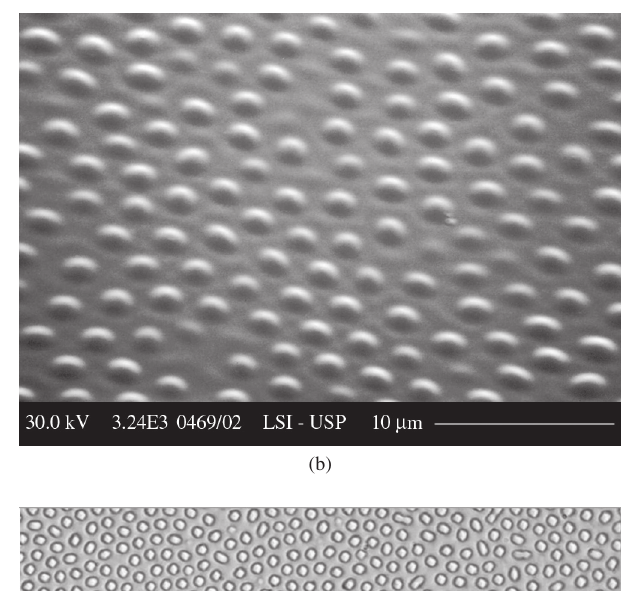
Figure 8. Frequency variation of PQC with a double layer film deposited on